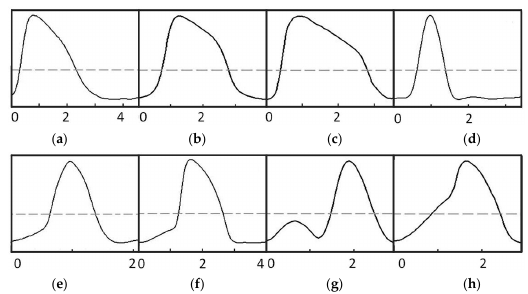
Figure 5. Eight typical EGG waveforms: ( a ) modal voice, ( b ) high adduction modal voice, ( c ) pressed voice, ( d ) untrained falsetto, ( e ) high adduction falsetto, ( f – h ) breathy voice.